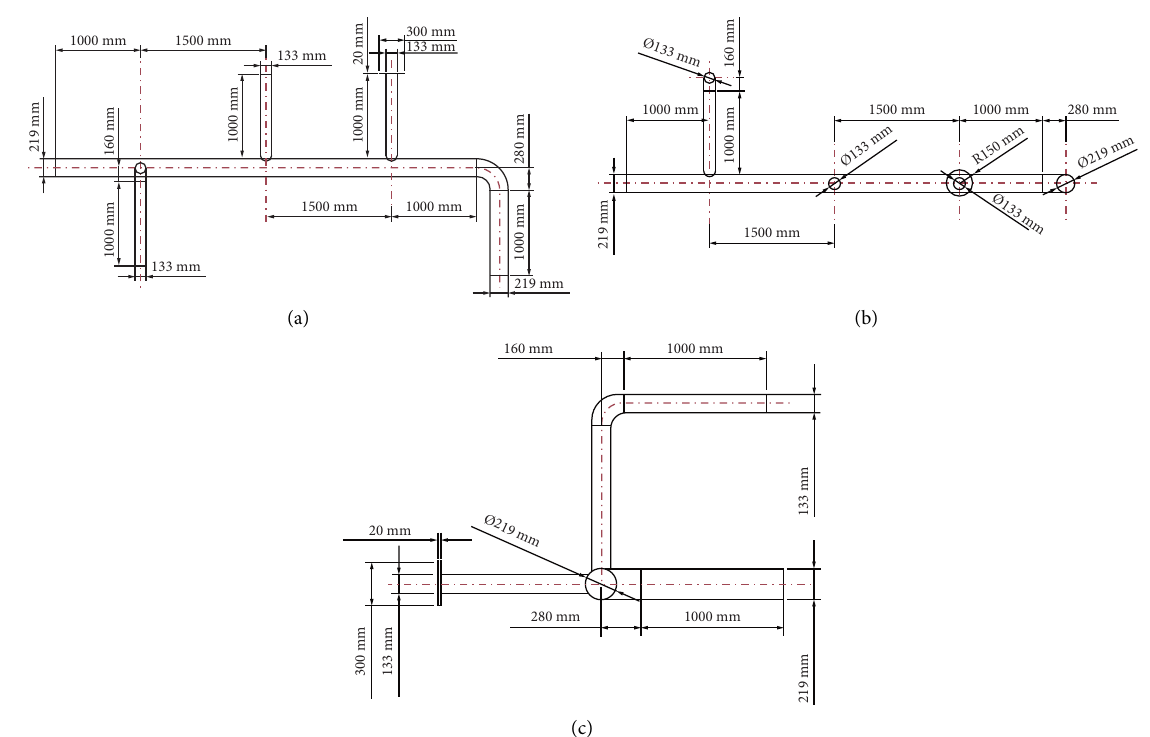
Figure 5: Tree views of the real-scale pipeline structure model: (a) top view, (b) front view, and (c) side view.